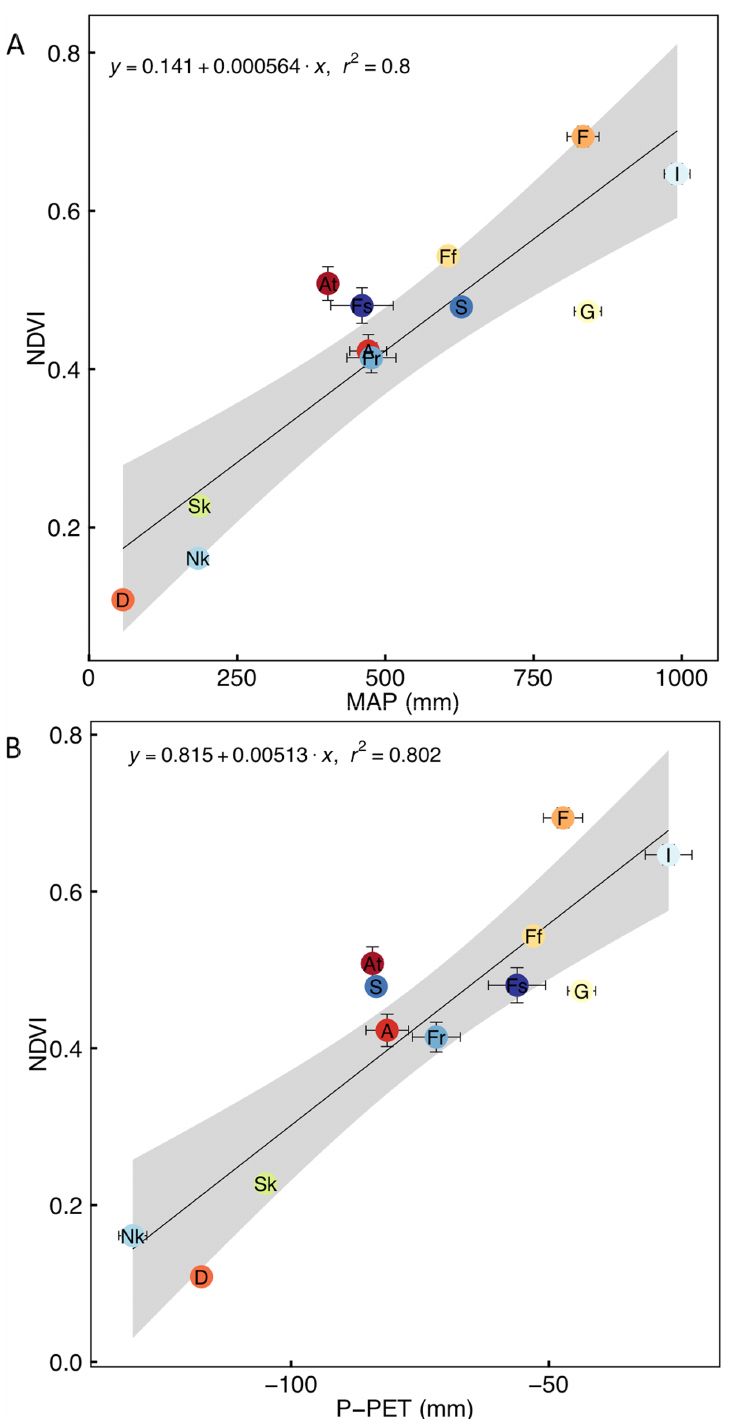
Fig 2. Correlation of annual average normalised difference vegetation index (NDVI) with (A) the average annual precipitation (MAP) and (B) water availability measured as the average of monthly precipitation (mm) – potential evapotranspiration (PET, mm) of each vegetation type. The vegetation types are indicated by codes (see Table 1). The coefficient of determination (r 2 ) is shown for significant relationships (P < 0.05). Points and error bars indicate mean ± SE (for n see Table 1) and the grey bands indicate the 95% confidence